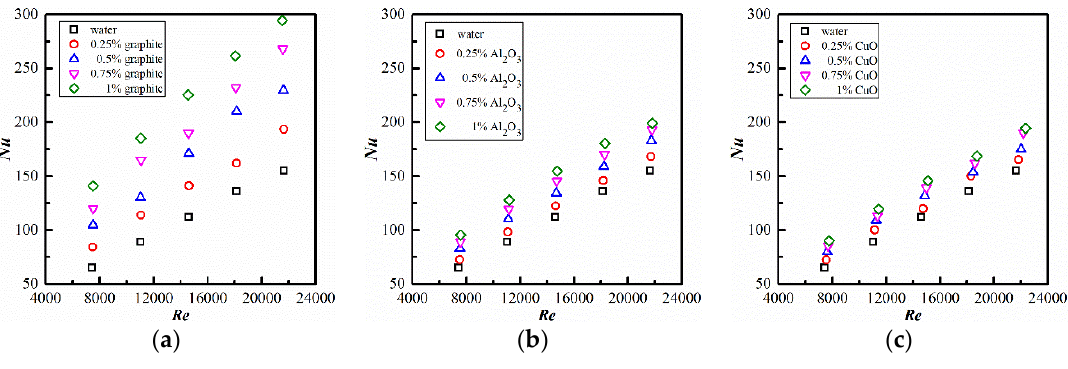
Figure 2. Variations of Nu with Re : ( a ) graphite; ( b ) A1 2 O 3 ; ( c ) CuO.